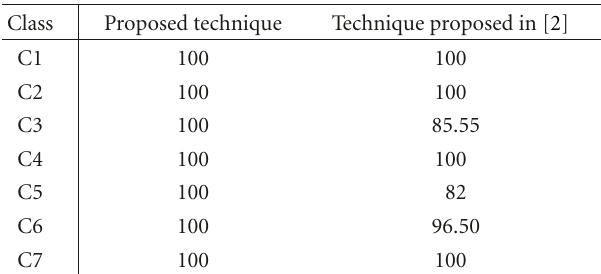
Table 6: Performance comparison in terms of classification ratio (%) achieved by proposed technique and the technique proposed in